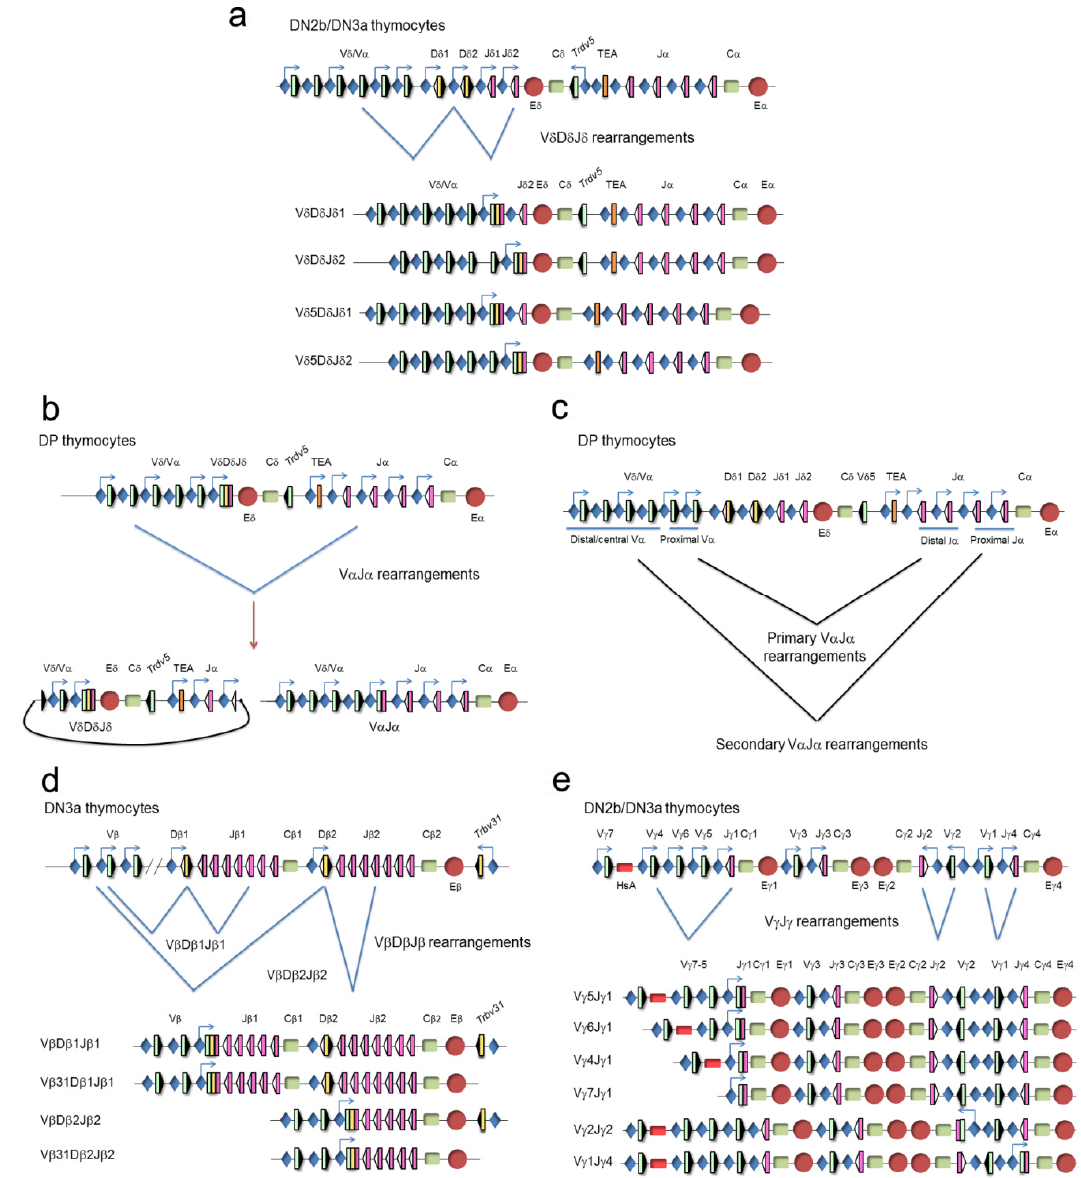
Figure 5. Genomic representation of the unrearranged and rearranged T-cell receptor (TCR) genes during thymocyte development. Rearrangements at the ( a ) TCR δ , ( b , c ) TCR α , ( d ) TCR β , and ( e ) TCR γ genes are represented. Variable (V), diversity (D), and joining (J) gene segments are represented by green, yellow, and pink rectangles, respectively. Recombination signal sequences (RSSs) are represented by triangles adjacent to the V, D, and J gene segments (black: RSSs with a 12-bp spacer and white: RSSs with a 23-bp spacer). Constant (C) regions are represented as green rectangles. The early α exon (TEA) is represented as an orange rectangle. Trypsinogen genes (T) are represented as brown rectangles. Enhancers are represented by red circles and promoters by blue diamonds, respectively. Germline transcription is indicated by blue arrows. At the TCR δ gene ( a ), V δ D δ J δ rearrangements occur in double-negative 2b (DN2b)/double-negative 3a (DN3a) thymocytes, whereas V α J α rearrangements occur at the TCR α gene in double-positive (DP) thymocytes ( b , c ). As a consequence of a primary V α J α rearrangement ( c ), the TCR δ gene is deleted from the genome as an extrachromosomal circle ( b ). At the TCR β locus ( d ), complete V β D β J β rearrangements occur in DN3a thymocytes. At the TCR γ locus ( e ), V γ J γ rearrangements occur in DN2b/DN3a thymocytes.